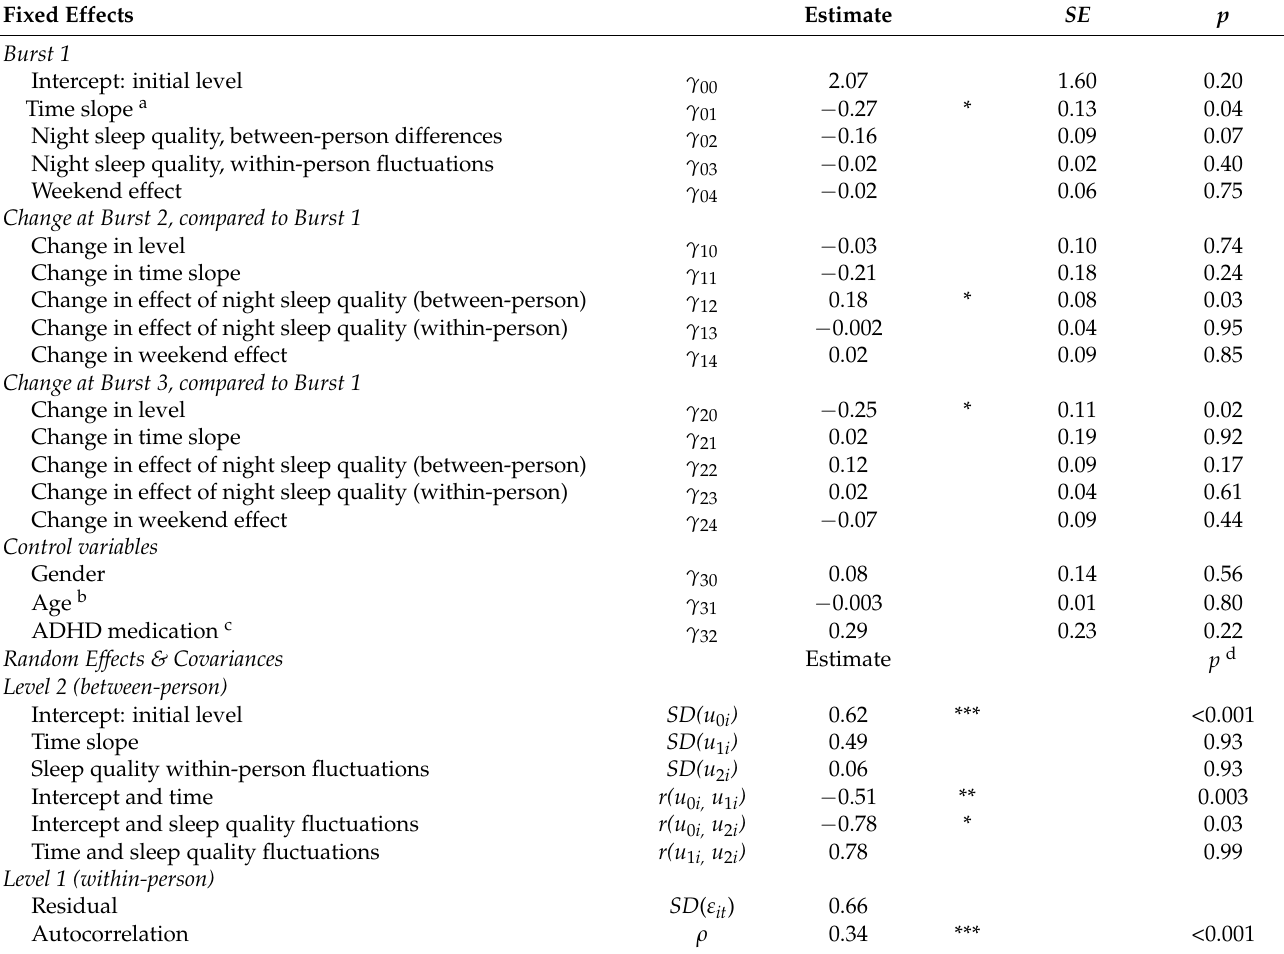
Table 2. Multilevel model to test the between- and within-person association between children’s night sleep quality and ADHD symptom levels the following